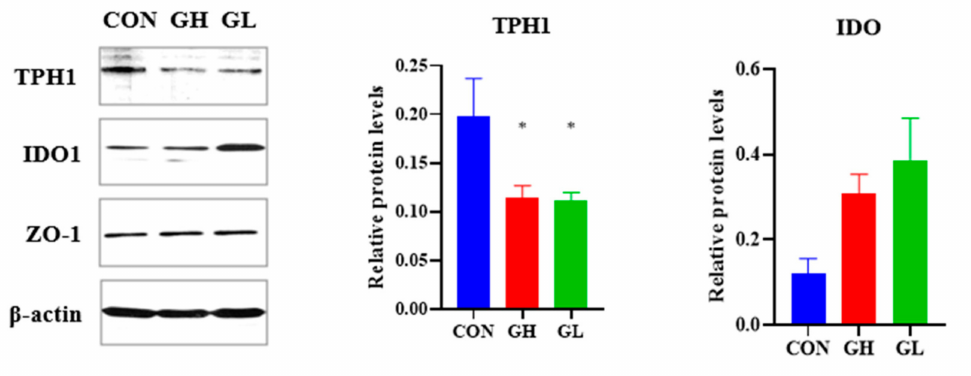
Figure 9. Western blot of rate-limiting enzymes that induced Trp metabolism in colon. * significant differences vs. CON group, p <